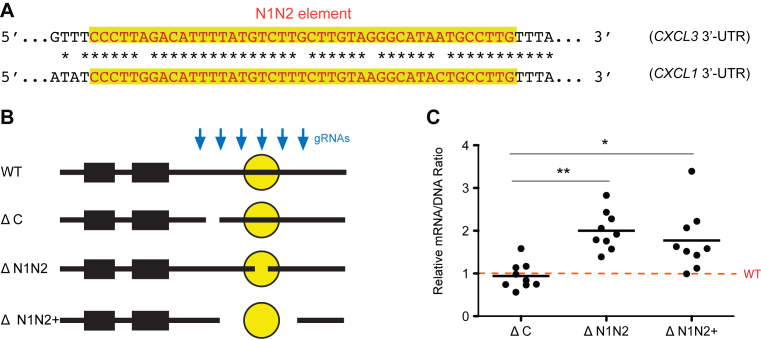
Targeting the N1N2 3′-UTR element in the native context increases CXCL3 expression. (A) The destabilizing element N1N2 (highlighted) in CXCL3 3′-UTR and a highly similar sequence from the CXCL1 3′-UTR. (B) A set of six gRNAs targeting the CXCL3 3′-UTR were used to create control deletions that were distant from the N1N2 element (ΔC), short deletions within N1N2 (ΔN1N2) and deletions resulting from a pair of gRNAs that removed N1N2 (ΔN1N2+). (C) Effect of CXCL3 deletions on mRNA level. Each dot represents one of the nine most abundant deletions of the class. *P < 0.05, **P < 0.01 by one-way ANOVA and Dunnett’s test.